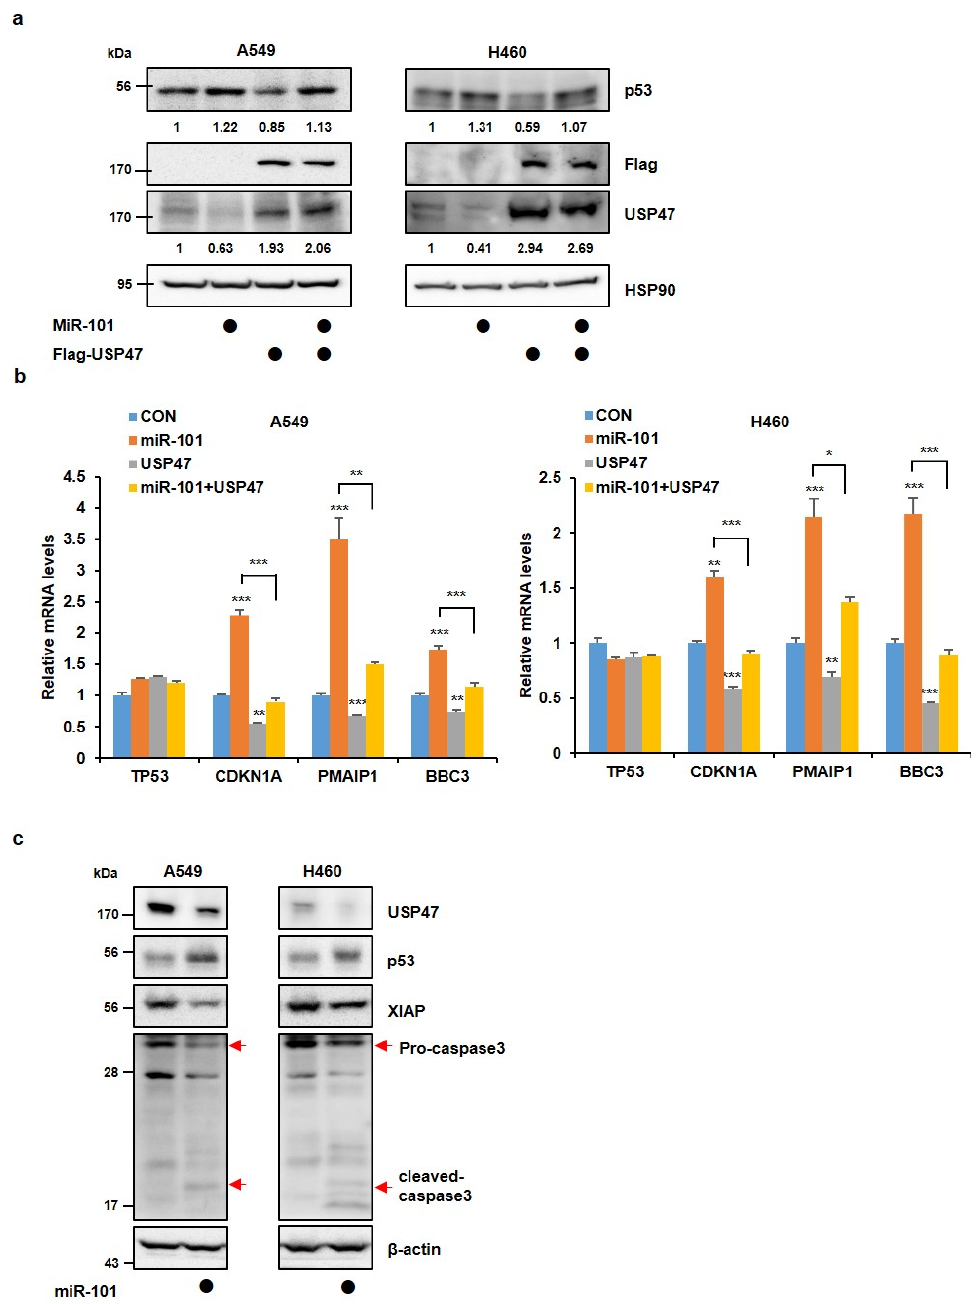
Figure 2. MiR-101-3p regulates p53 functions by targeting USP47. ( a , b ) A549 and H460 cells were transfected with a miR-101-3p mimic or Flag-USP47 alone, or together. ( a ) Western blot analysis was performed to detect the p53 protein level. ( b ) Q-PCR analysis was conducted to determine the relative expression levels of p53 and its target genes. ( c ) A549 and H460 cells were transfected with a miR-101-3p mimic. Western blot analysis was performed to detect apoptotic proteins. The data in part ( b ) represent the mean ± SD (* p < 0.05, ** p < 0.005, *** p < 0.0005, t -test).